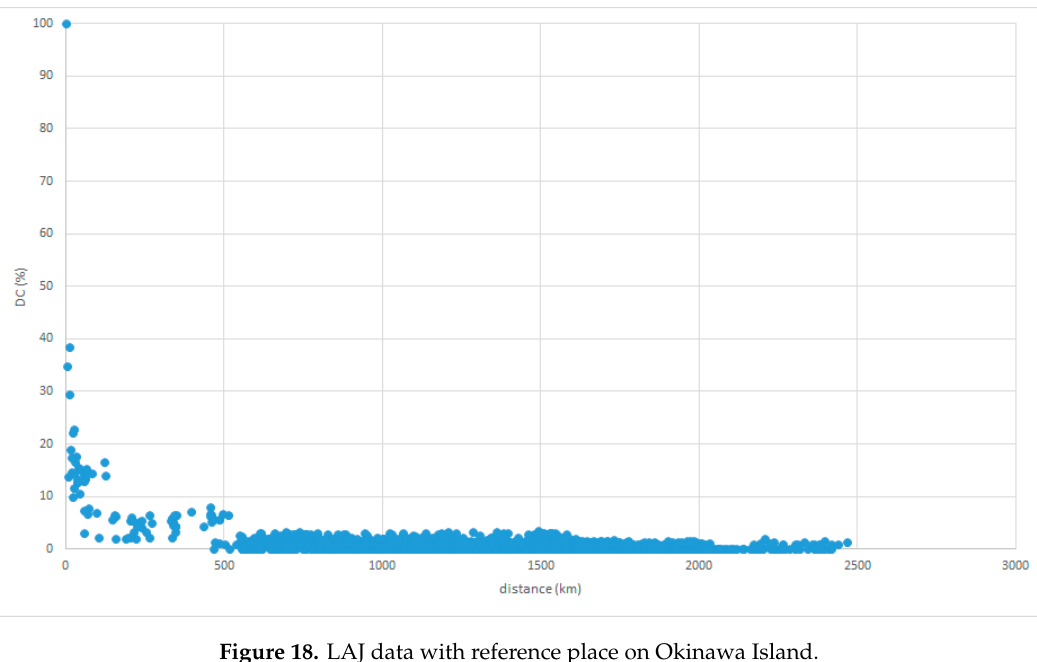
Figure 18. LAJ data with reference place on Okinawa Island.